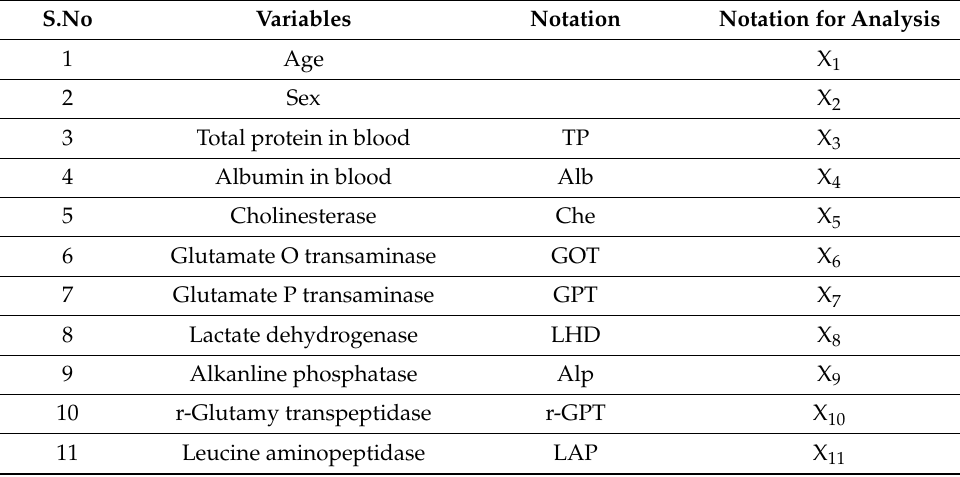
Table 6. Variables in the liver disease diagnosis and notations for the